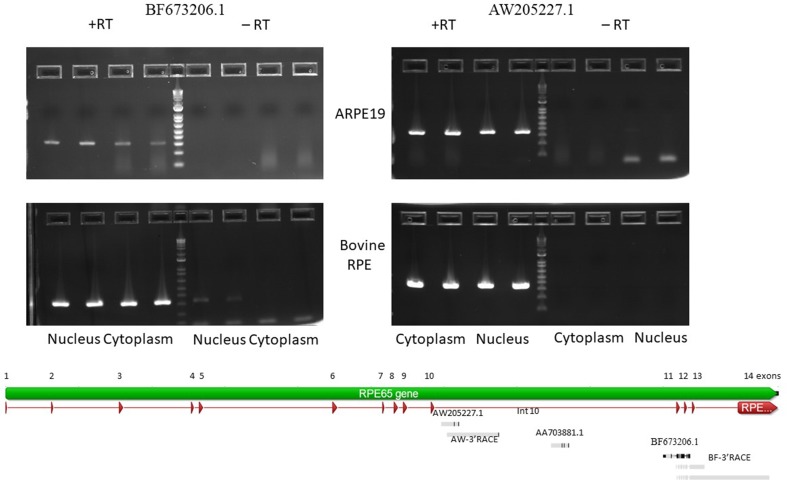
Agarose gel electropherogram of PCR products of BF673206.1 and AW205227.1 EST from cDNA and no RT control from 4M_ARPE-19 and native bovine RPE cells. Graphical representation of alignments of the EST and RACE products on to RPE65 gene (Geneious 9.1.5).